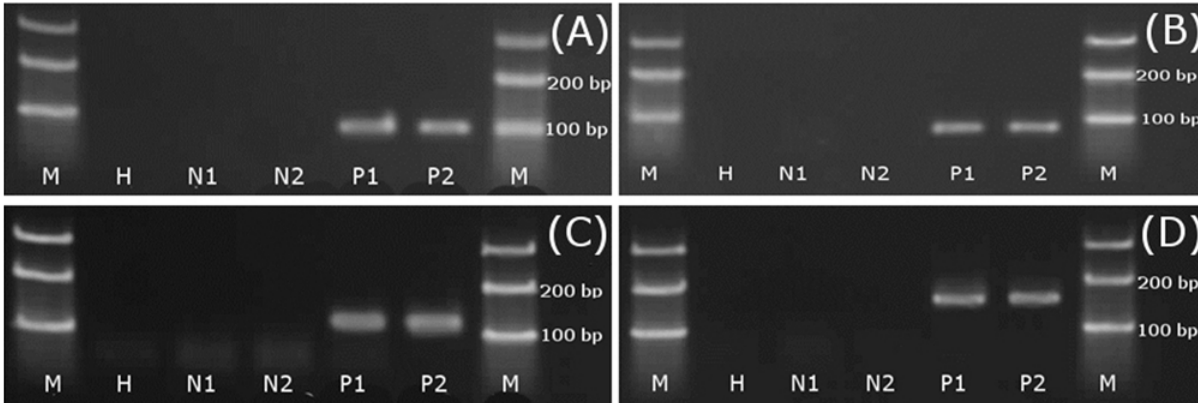
Figure 1. Electrophoreograms of PCR products obtained from RT-PCR using the specific primers designed for RT-qPCR purposes. (A): ApMVXF1/ApMVXR1 (87 bp); (B): ASGVF1/ASGVR1 (70 bp); (C): ASPVF3/ASPVR3 (104 bp); and (D): ACLSVF2/ACLSVR2 (148 bp). [(M): DNA marker (O’RangeRuler 20 bp DNA Ladder, Fermentas); (H): RT-PCR